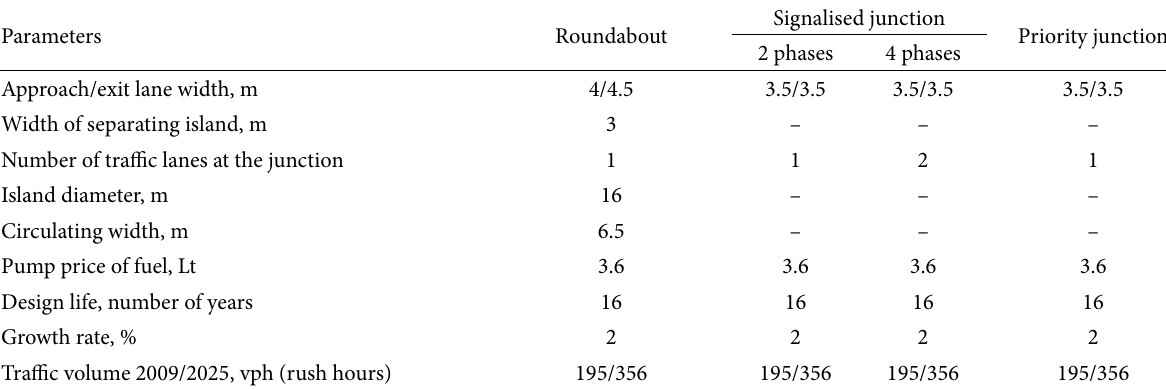
Table 2. Parameters of the modelled junction